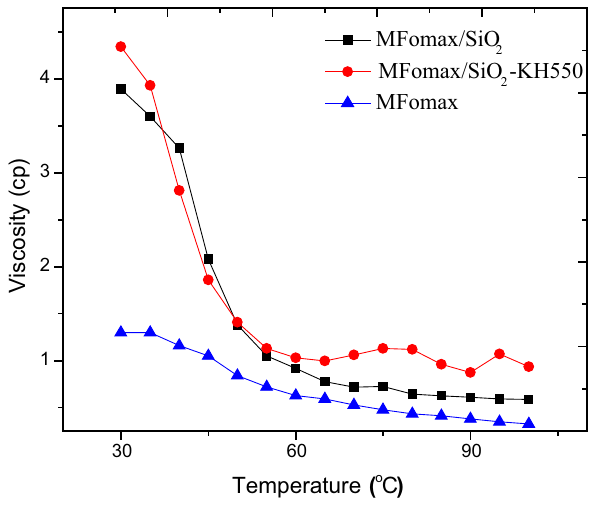
Fig. 6 Temperature effect on the viscosity of the NFs in comparison with the base case MFomax ramped from 30 to 90 °C at 50 s −1 shear